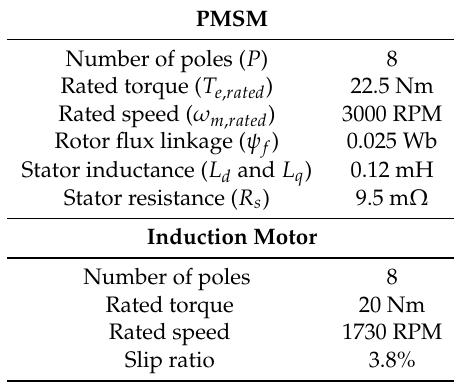
Figure 6. Block diagram of the experimental system. Table 1. Electrical parameters of the PMSM and the induction